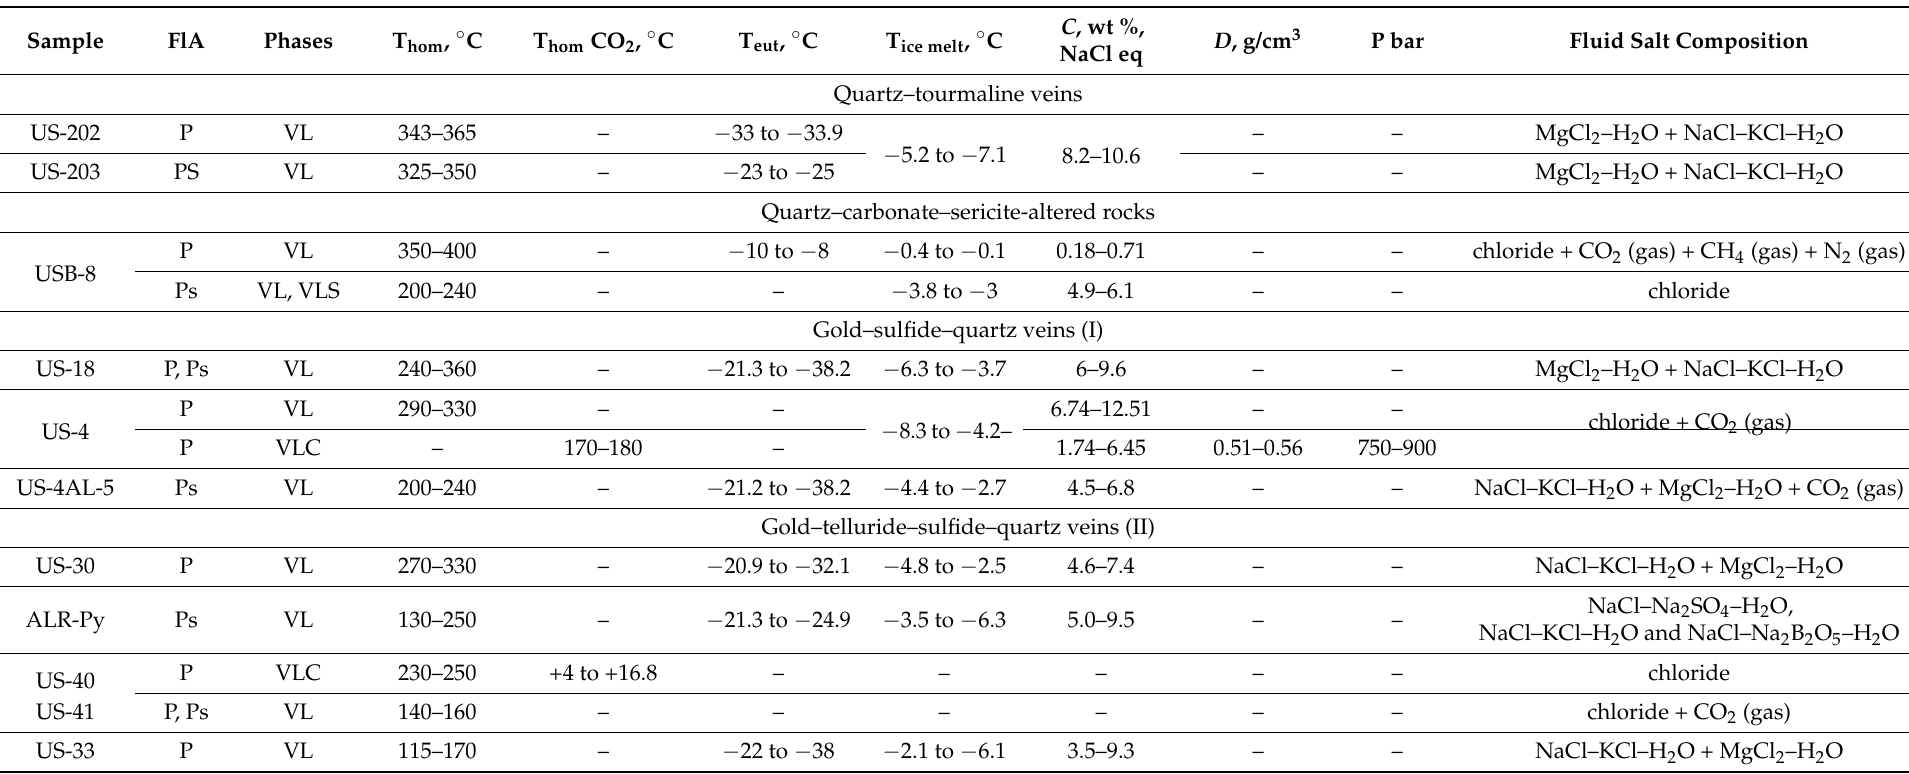
Table 3. Fluid inclusion data of the Ulug-Sair ore